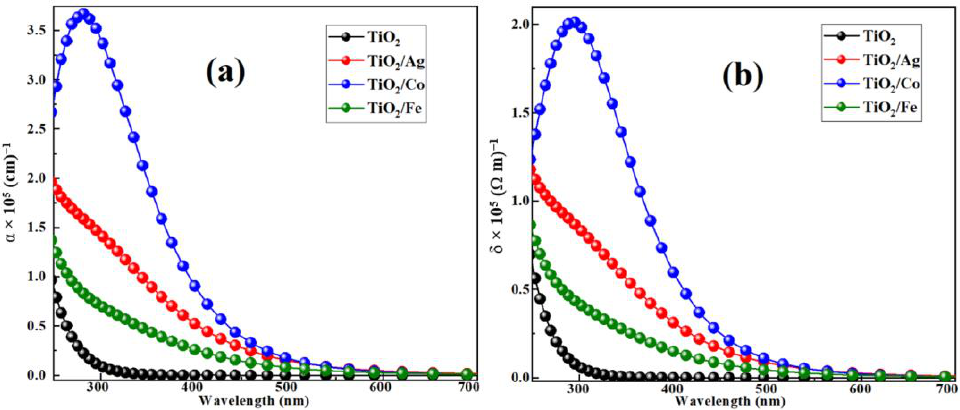
Figure 7. ( a ) Absorption coefficient and ( b ) optical conductivity of pure and metal doped TiO 2 anatase.